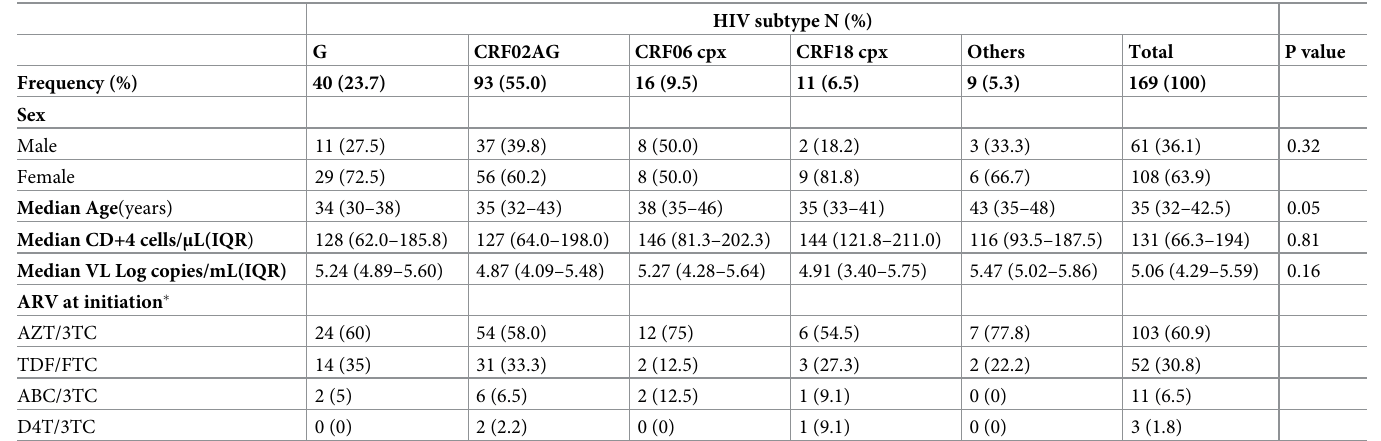
Table 1. Baseline demographics and clinical characteristics of the study population by subtypes.